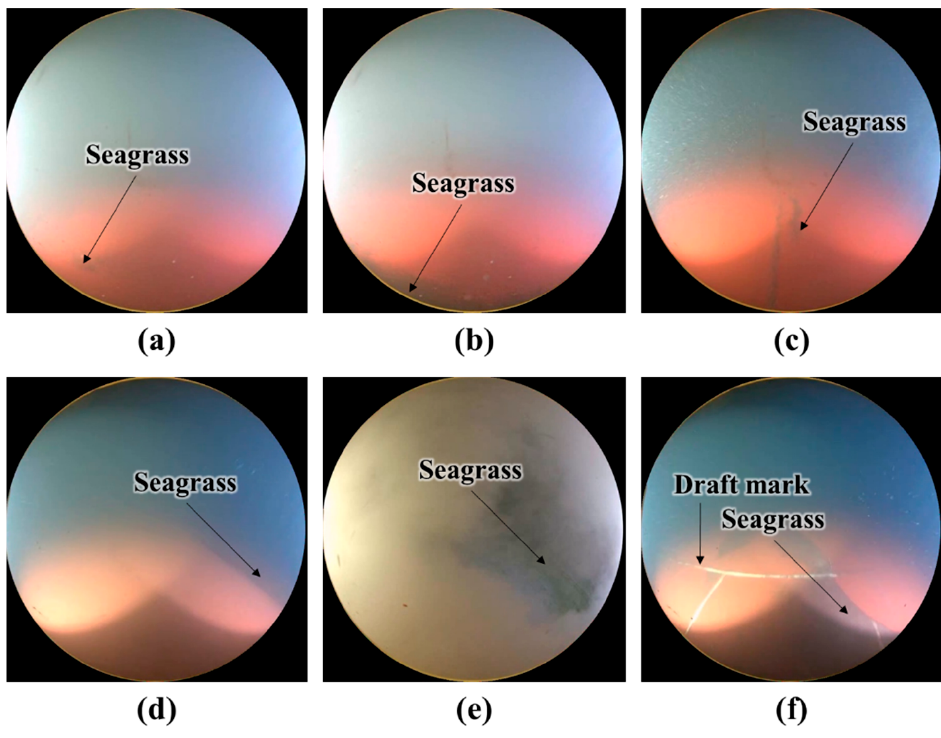
Figure 7. Examples of mis-classified images with the soft voting ensemble classifier: ( a – c ) False positive and ( d – f ) false negative.